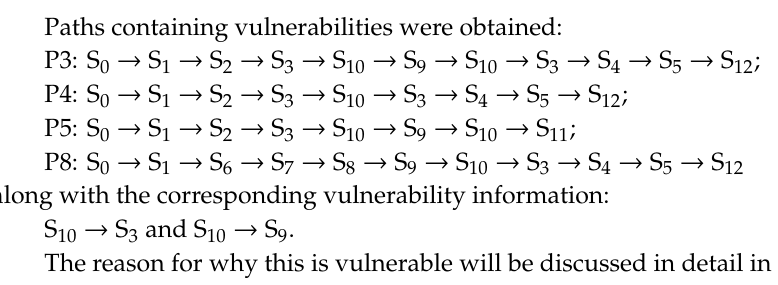
Figure 10. Output of vulnerability determination algorithm under the goal of integrity.